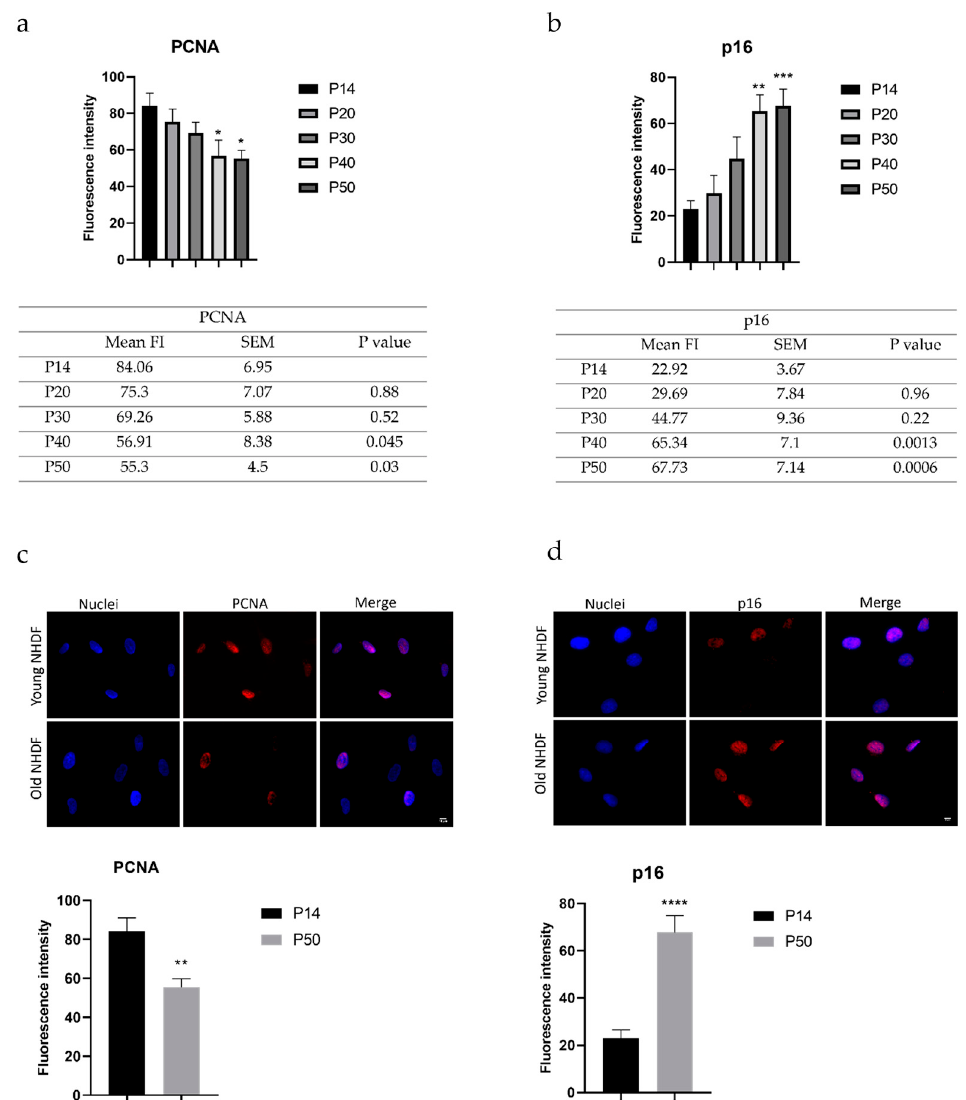
Figure 1. Histograms and tables showing data concerning the two chosen markers of proliferation or aging: ( a ) PCNA and ( b ) p16, evaluated at selected culture passages, i.e., passages 15, 20, 30, 40, and 50 (data expressed as mean of fluorescence intensity ± standard error of the mean); * p < 0.05, ** p < 0.01, *** p < 0.001, **** p < 0.0001 compared to P14 as determined by one-way Anova. ( c ) Immunofluorescent labeling for PCNA protein (in red); DNA was stained with Hoechst 33258 (blue fluorescence). Magnification 60×; scale bar: 10 μ m. The histograms show the fluorescence intensity value of the immunolabeling in young (passage 14) and old (passage 50) NHDF. ** Student’s t-test : p < 0.01; ( d ) Immunofluorescent labeling for p16 protein (red fluorescence); DNA was stained with Hoechst 33258 (blue fluorescence). Magnification 60×; scale bar: 10 μ m. The histograms show the fluorescence intensity value of the immunolabeling in young (passage 14) and old (passage 50) NHDF. **** Student’s t-test : p < 0.001.